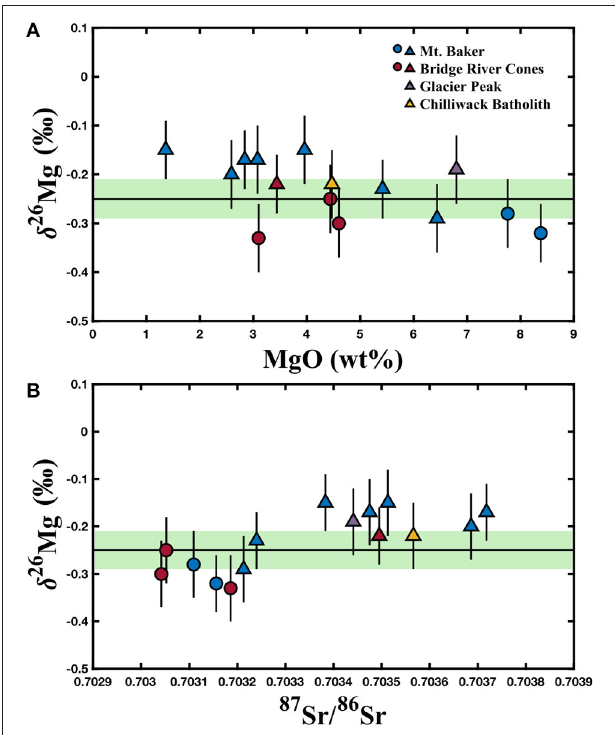
FIGURE 3 | (A) Variation of δ 26 Mg with wt% MgO. (B) Variation of δ 26 Mg with 87 Sr/ 86 Sr. The colored circles represent those samples identified as most primitive from Mt. Baker and the Bridge River Cones, while the colored triangles represent samples that exhibit crustal contamination. The black line and green bar represent the mantle composition based on peridotite xenoliths ( δ 26 Mg = − 0.25 ± 0.04 ‰ ) from Teng et al. (2010a). North Cascades data are reported in Table 1. Error bars represent the 2 SD for each sample.